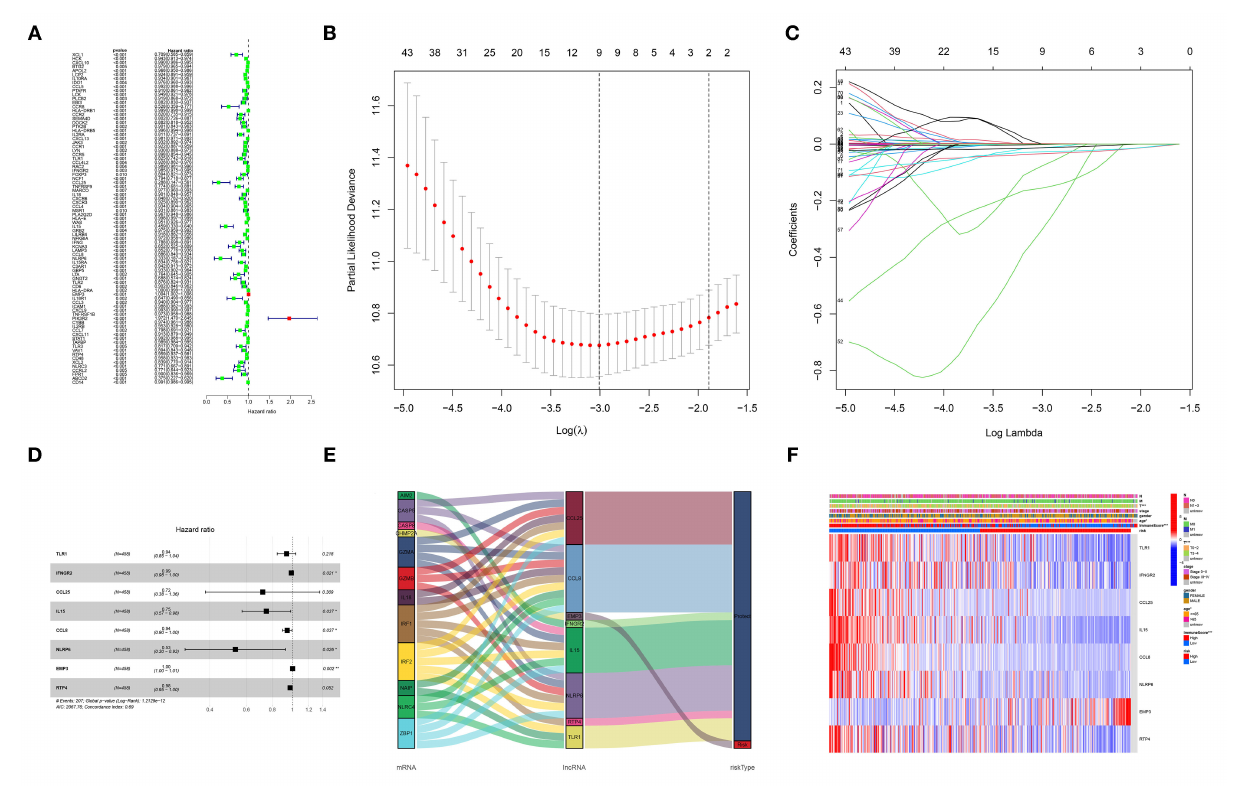
FIGURE 3 | Construction of the GRIP signature. (A) Forest map of 83 prognostic GRIPs identified by univariable Cox regression. (B,C) Lasso regression lambda.min and lambda.1se criteria, parameter. (D) Multivariable Cox regression model. (E) A Sankey diagram shows the relationship between GRIPs and the risk type (risk or protect). (F) The heatmap illustrates the association between the eight GRIPs and clinicopathological characteristics.